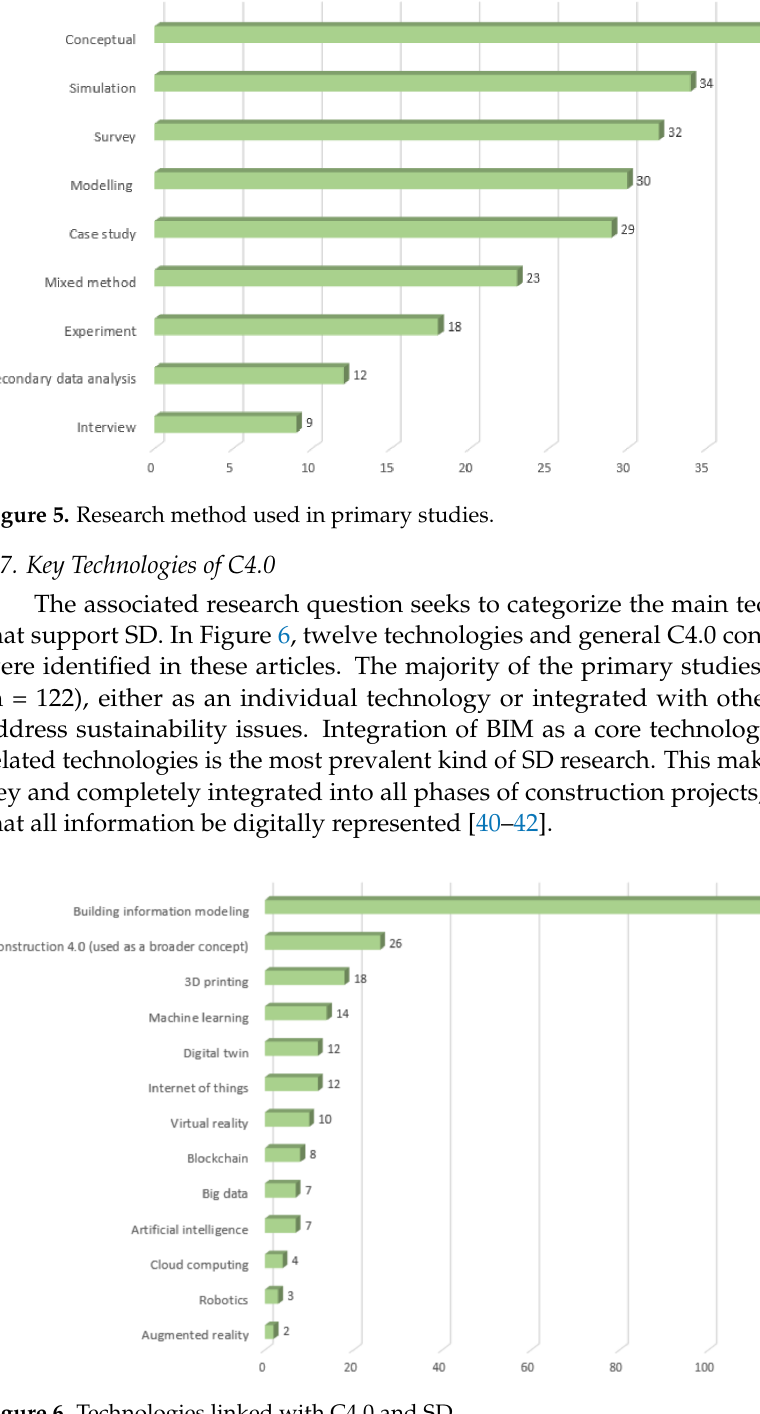
Figure 6. Technologies linked with C4.0 and